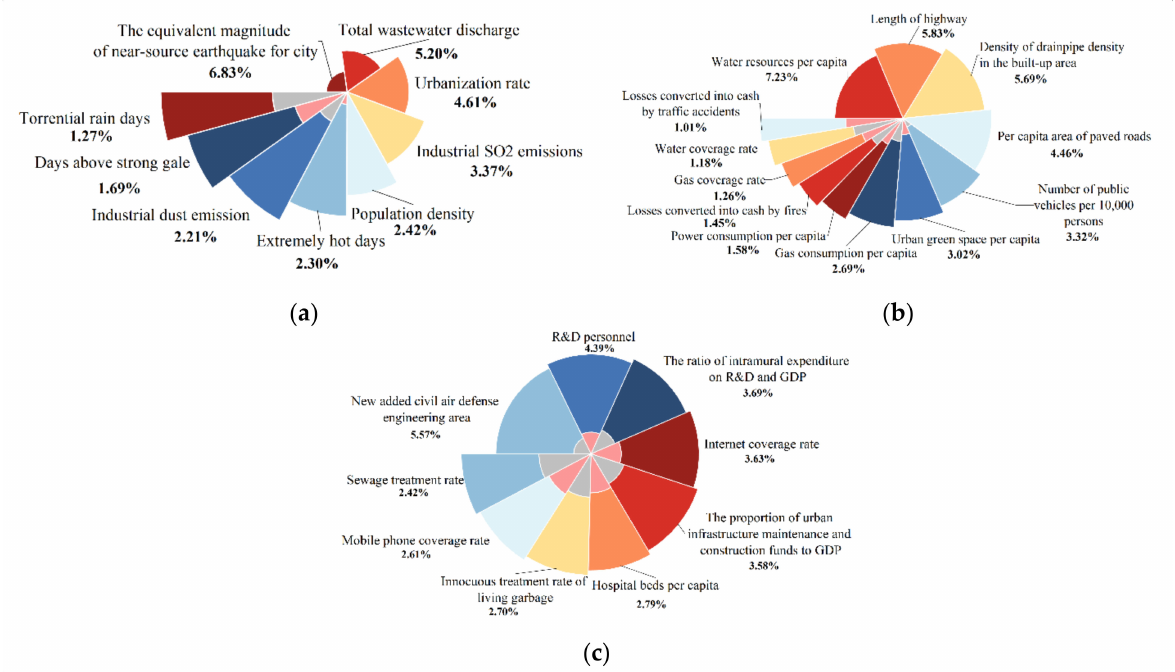
Figure 2. Weight proportions of function layer and criterion layer in the evaluation system. ( a ) Weight of pressure layer index; ( b ) Weight of state layer index; ( c ) Weight of response layer